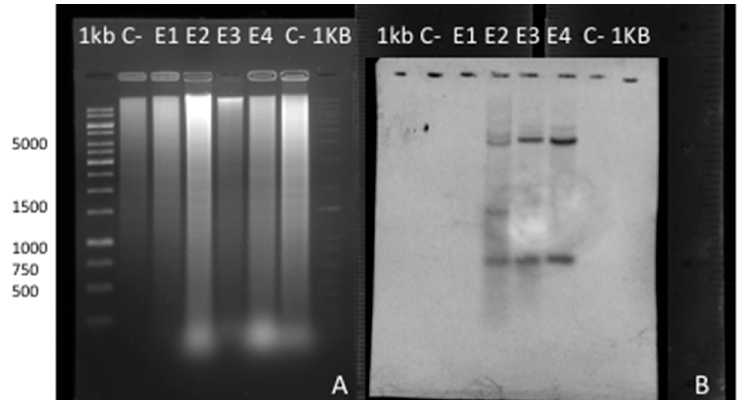
Figure 4. Southern blot analysis of transgenic coffee plants. ( A ) Southern blot hybridization analysis of regenerated plants of C. arabica digested with EcoR1. ( B ). The blot was hybridized with Biotin labeled cry10Aa 1996 bp fragment. Lanes E1, E2, E3, and E4 correspond to genomic DNA from three independent transformation events. C-lane: DNA extracted from an untransformed control plant.